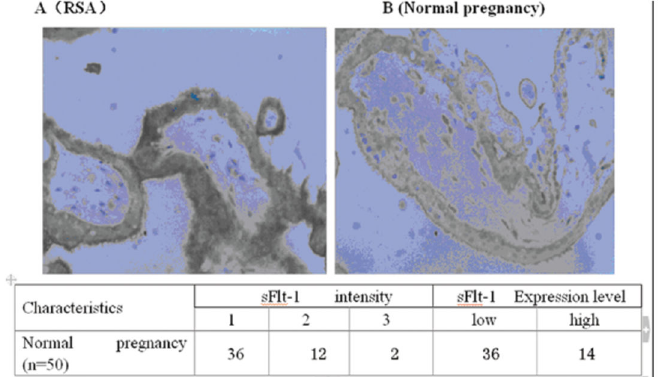
Figure 4. Immunohistochemistry for sFlt-1 protein expression in chorionic villus. sFlt-1 protein was expressed in the chorionic villus located in the cytoplasm (Original magnification ×600. sFlt-1 intensity by immunohistochemistry staining was